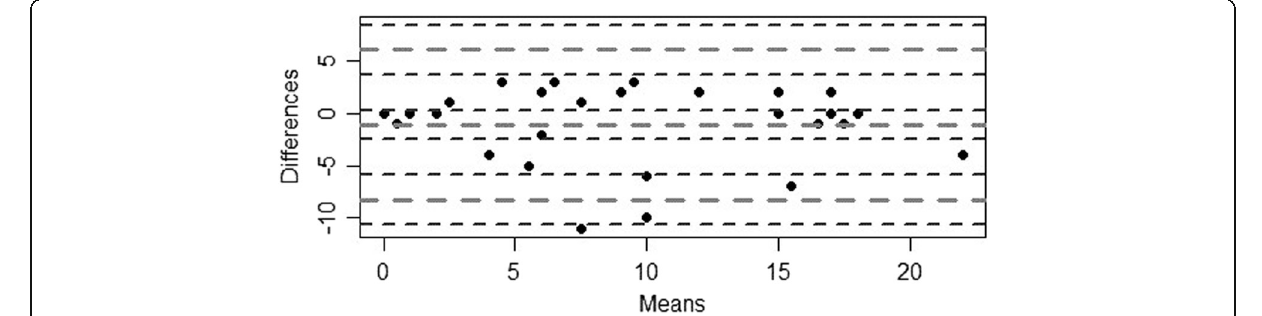
Fig. 1 Bland-Altman Plot of the Portuguese version of total FIHOA score for test and retest with 95% CI